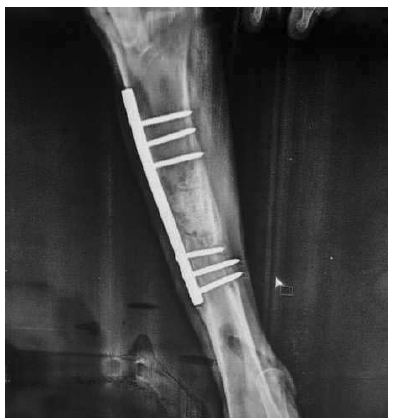
Figure 3: Immediate post operative radiograph.